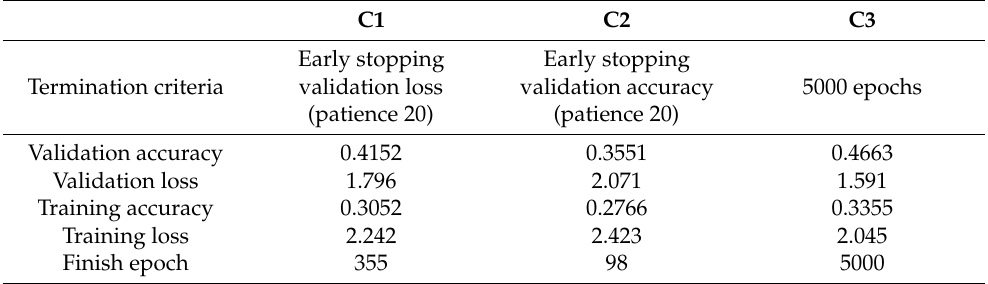
Table 2. Termination criteria results.